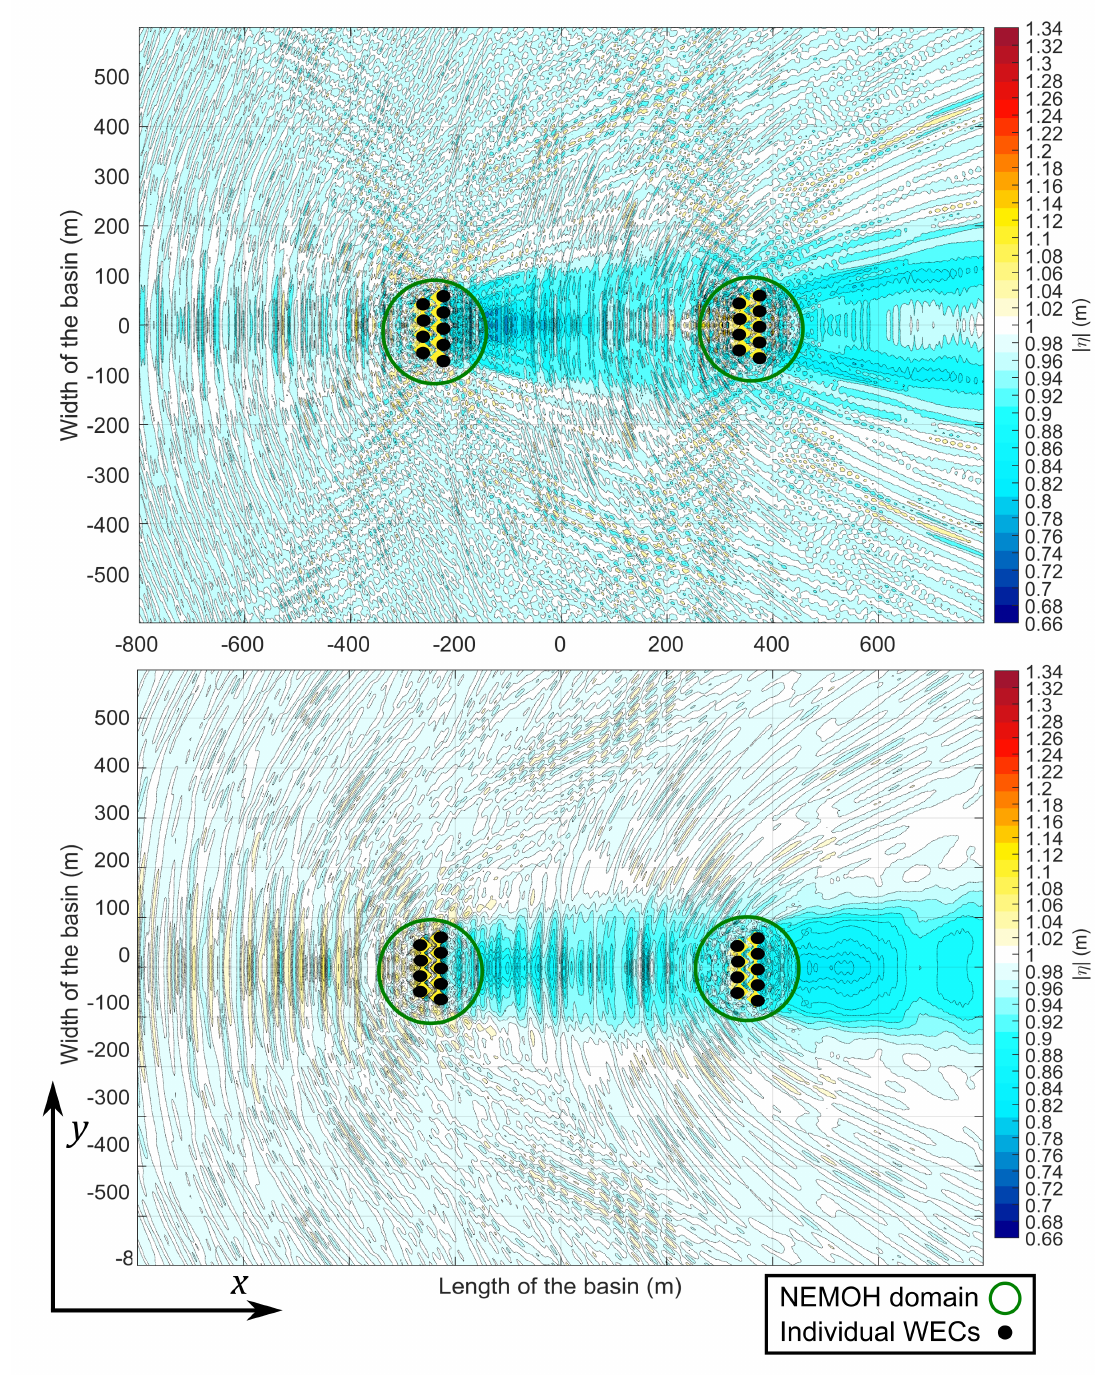
Figure 10. Total wave field around two WEC arrays, I (left) and II (right), of nine heaving buoys for Pierson–Moskowitz irregular waves of H m 0 = 2 m, T p = 6 s (top row) and T p = 8 s (bottom row). Interarray separation distance and D 1 = 600 m or 6 r c . Wave incidence angle β = 0 ◦